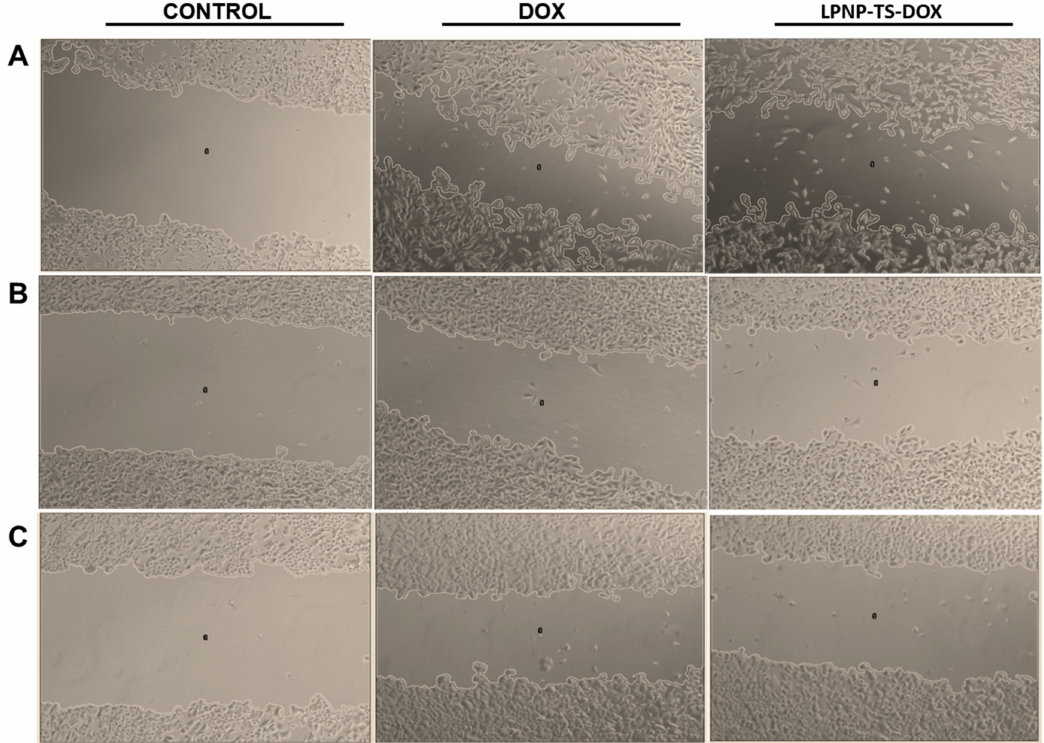
Figure 7. Phase-contrast photomicrographs of the “zero wound” (control) and wounds of ( A ) 4T1, ( B ) MDA-MB-231, ( C ) MCF-7 cell lines, exposed to 500 nM of DOX(free or encapsulated into LPNP), for 24 h at 37 ◦ C. Amplification 5 ×